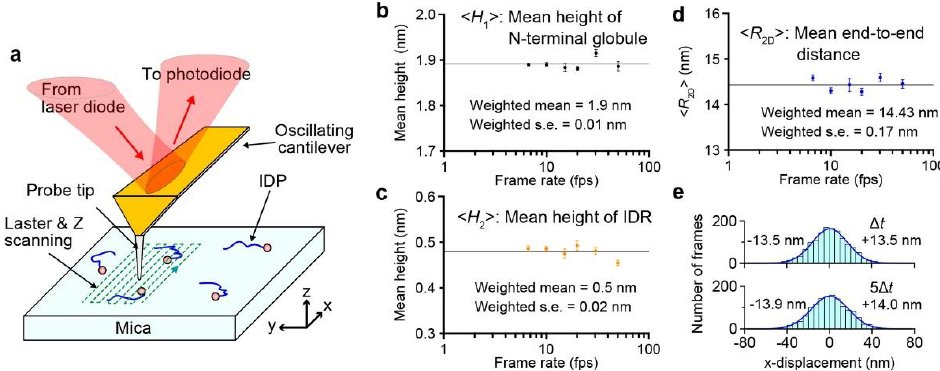
Figure 1. Absence of tip disturbance to the structure of IDPs. ( a ) Schematic showing HS-AFM imaging of IDP molecules placed on mica surface. ( b – d ) Molecular features of PQBP-1 (1–214) measured by HS-AFM at various imaging rates (6.7–50 fps): ( b ) Mean height of N-terminal globule, ( c ) mean height of IDR, and ( d ) mean 2D end-to-end distance of IDR. ( e ) Distributions of C-terminal end displacements in the X-direction were observed for WT PQBP-1 during time periods of ∆ t and 5 ∆ t . ∆ t is one frame acquisition time (42 ms). The numbers shown on each panel are the mean displacements in the + X and − X directions. Note that the IDR within PQBP-1 is constantly disordered.